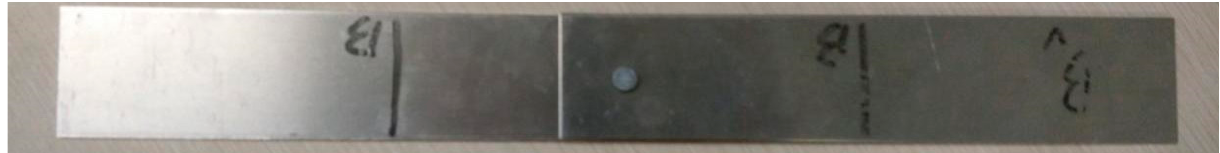
Figure 7. Riveting test piece.